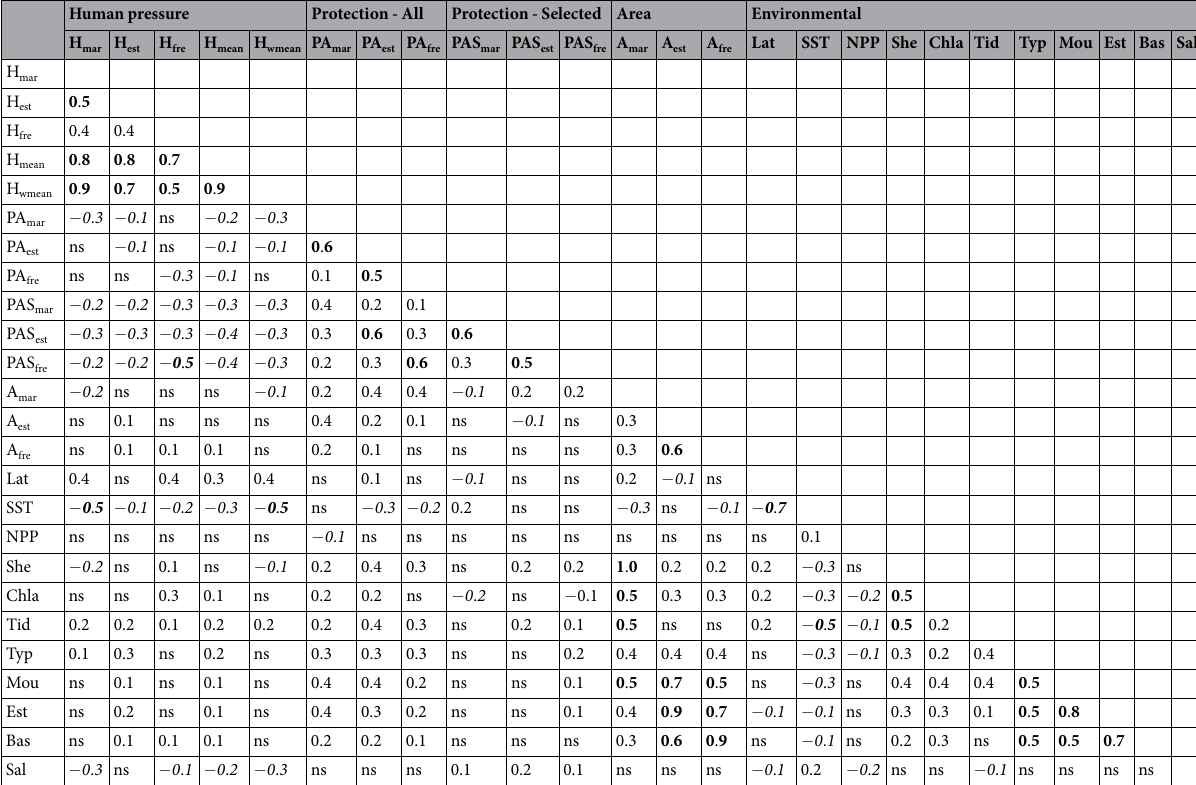
Table 3. Pairwise Pearson correlation between intensity of human pressure (H), percentage of coverage by protected areas (PA), percentage of coverage by selected areas of IUCN management categories I-IV (PAS), area used for estimation of pressure and protection (A, in km 2 ), and environmental variables in and around estuaries distributed worldwide. Each variable about human pressure and protection was estimated for marine